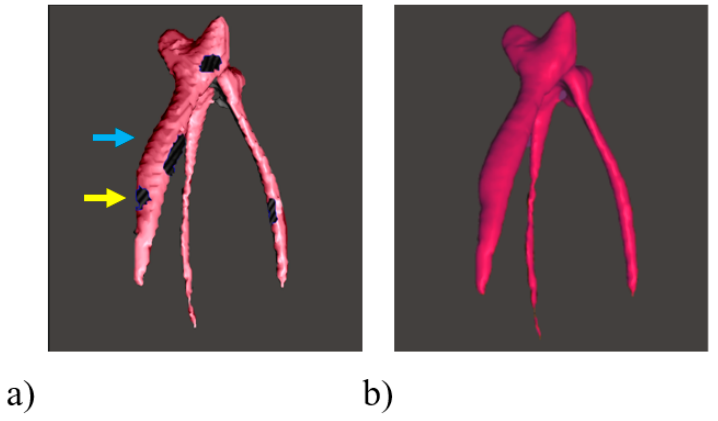
Figure 4. Cleaning and repairing the 3D file of a segmented pulp using the free software Meshmixer (Autodesk, San Rafael, EU). ( a ) STL presenting holes (yellow arrow) and stair-steps (blue arrow) due to the resolution of the cone beam computed tomography, could be automatically smoothed and repaired using “Smooth” and “Inspector” tools in the software ( b ).